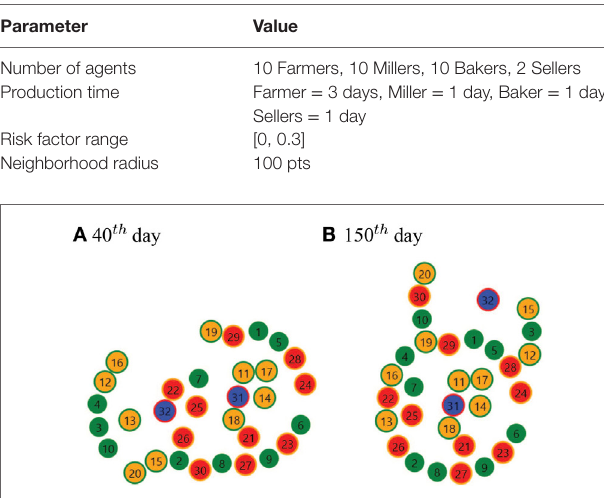
TaBle 6 | initial conditions for experiment #4.